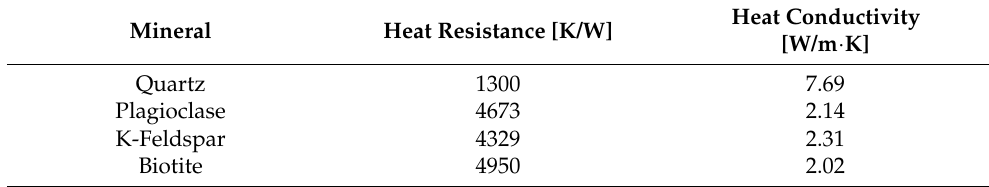
Table 5. Heat characteristics of minerals in granite [18].